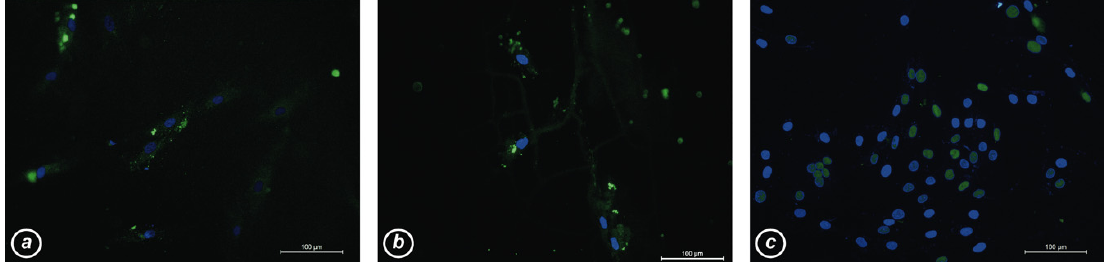
Figure 4. MyoD1 subcellular localization. ( a ) Human circulating multipotent stem cells (hCMCs) grown onto 1 wt% CNH@PLLA for 9 days; ( b ) hCMC grown onto 1 wt% CNH@PLLA for 14 days; ( c ) myoblasts seeded on well.